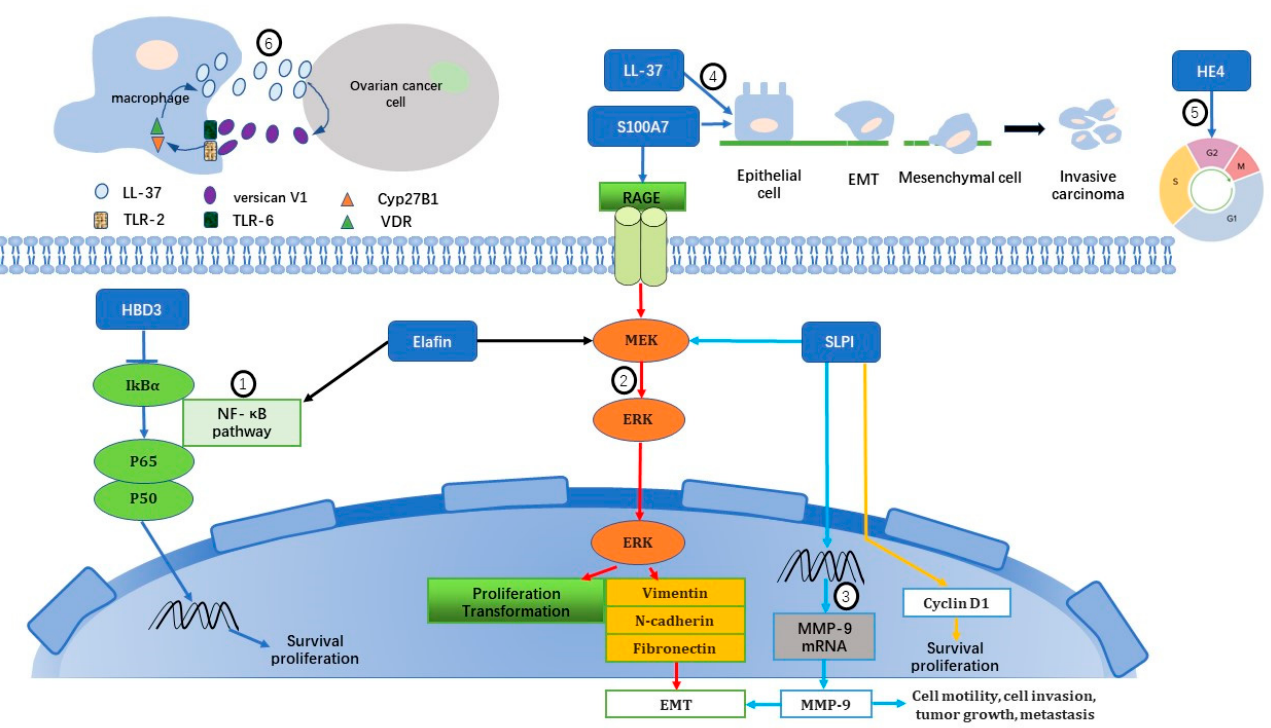
Figure 1. Tumorigenic and pro-metastatic mechanisms of AMPs on gynecological cancers: (1) HBD3 and elafin activate NF- κ B pathway [12,95]; (2) Elafin, S100A7 and SLPI induce MEK/ERK pathway [58,68,87,95,96]; (3) SLPI promotes extracellular matrix remodeling and angiogenesis [68,97]; (4) LL-37 and S100A7 induce epithelial-mesenchymal transition (EMT) [58,98]; (5) HE4 controls cell cycle [91]; (6) A vicious circle between macrophages and ovarian cancer cells by interaction between LL- 37 and versican V1 [99]. MEK, Mitogen-activated protein kinases; ERK, Extracellular signal-regulated kinases; RAGE, Receptor for advanced glycation end-products; EMT, Epithelial–mesenchymal transition; VDR, vitamin D receptor; TLR, Toll-like receptor; MMP, Matrix metalloproteinases; CYP27B1, Cytochrome P450 family 27 subfamily B member 1.